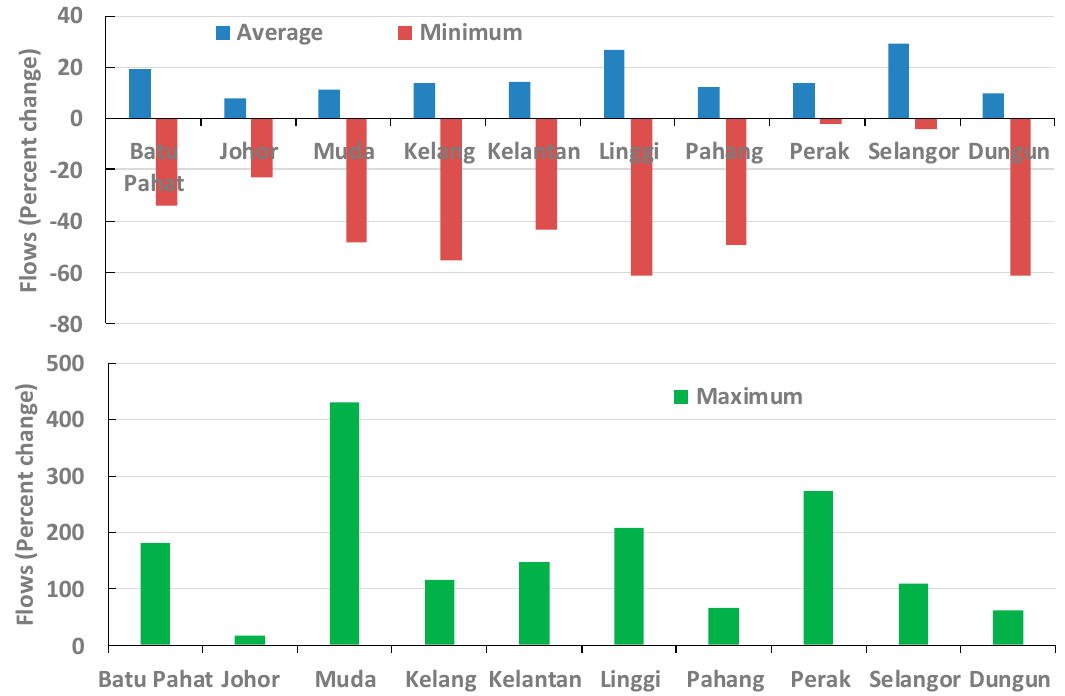
Figure 11. Percent change in values of the mean monthly river flows during the 2010–2100 period from those during the 1970–2000 period. The percent changes are calculated for average, minimum, and maximum mean monthly flows.